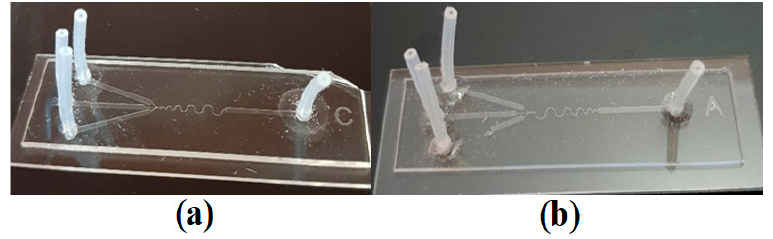
Figure 14. PDMS Microchannels ( a ) 5CACMC ( b ) 5CDCMC.